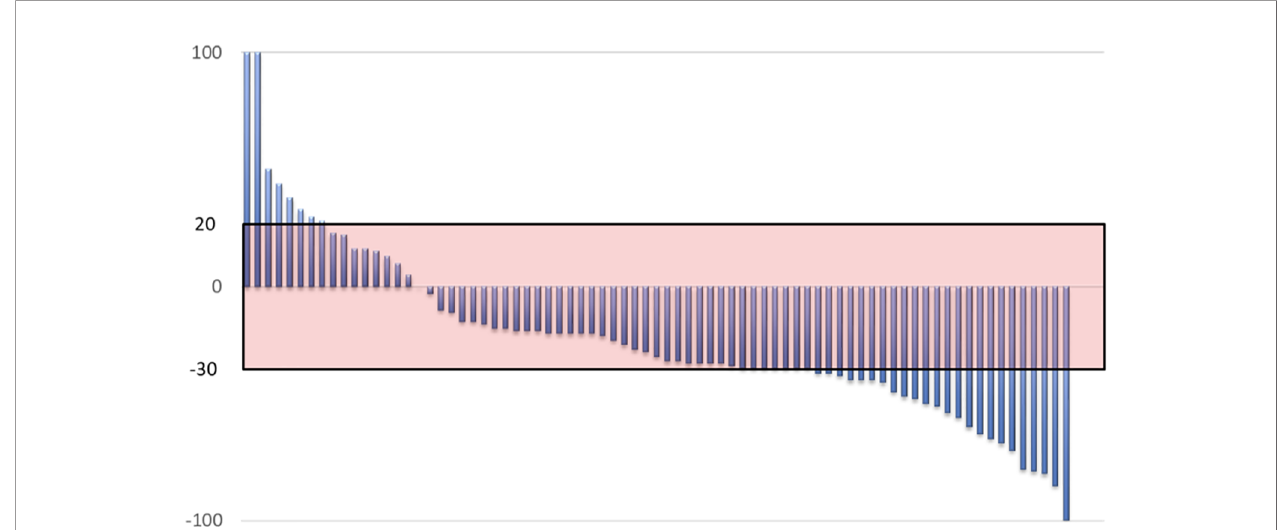
FIGURE 1 | Waterfall plot representing the best response to CIGC by each individual patient.